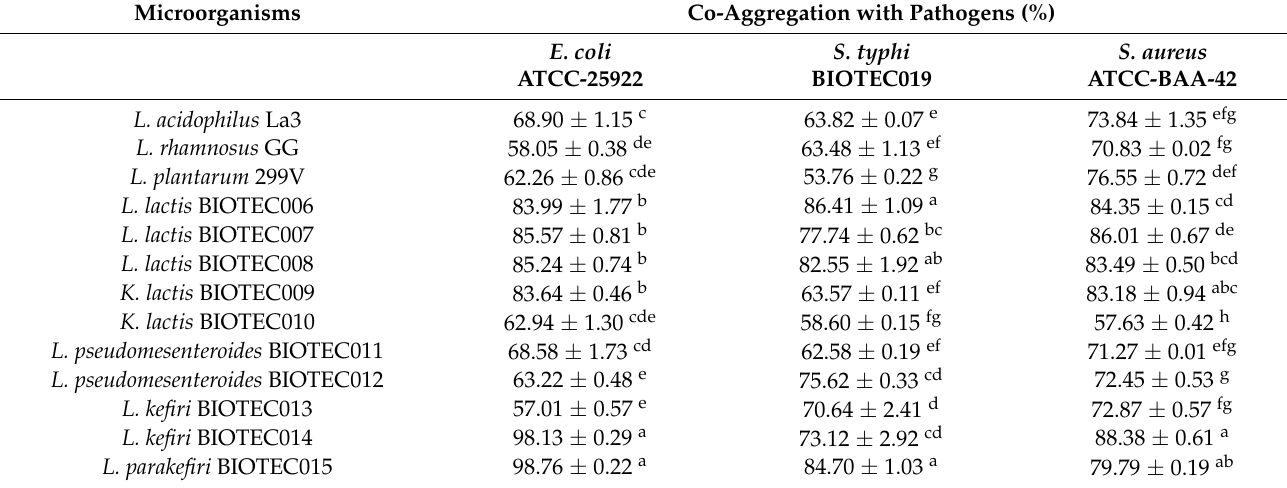
Table 3. Co-aggregation abilities of isolates and controls with E. coli ATCC-25922, S. typhi BIOTEC019, and S. aureus ATCC-BAA-42 at 24 h a